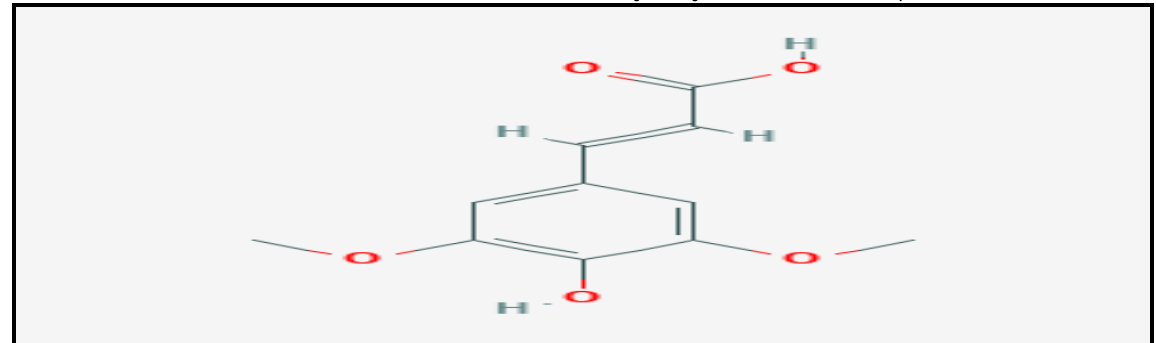
Figure 23. Chemical structure of Sinapic acide with molecular weight 224 Gram/mol